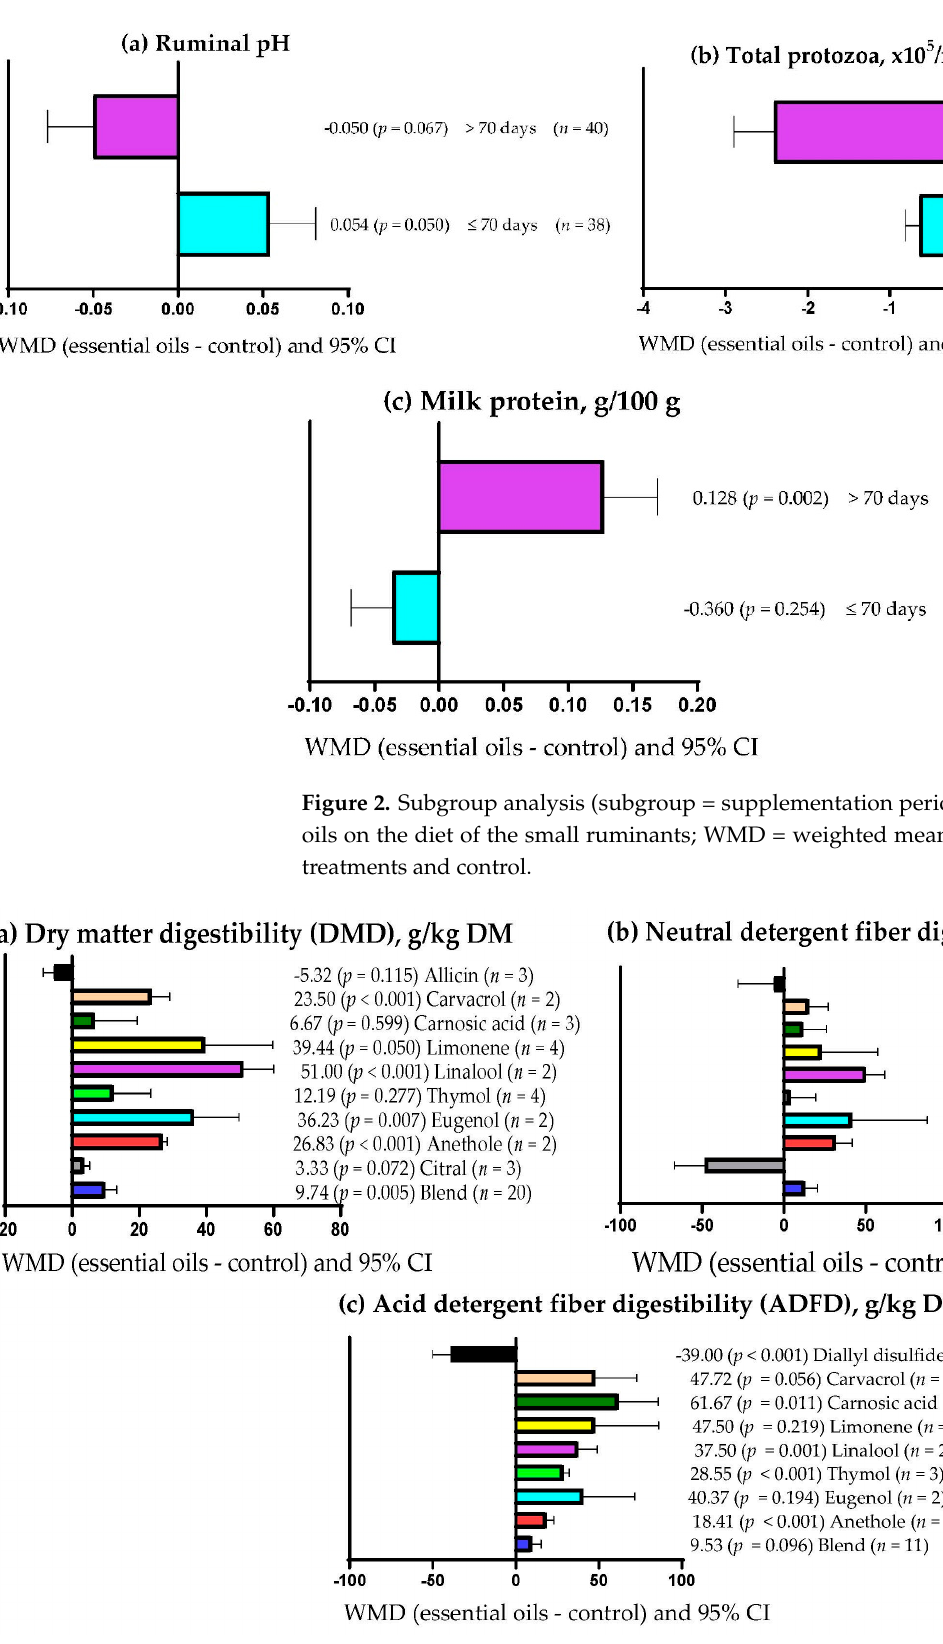
Figure 3. Subgroup analysis (subgroup = primary bioactive compound) of the effect of essential oils supplementation to small ruminants’ diets on their digestibility; WMD = weighted mean differences between essential oil treatments and control.